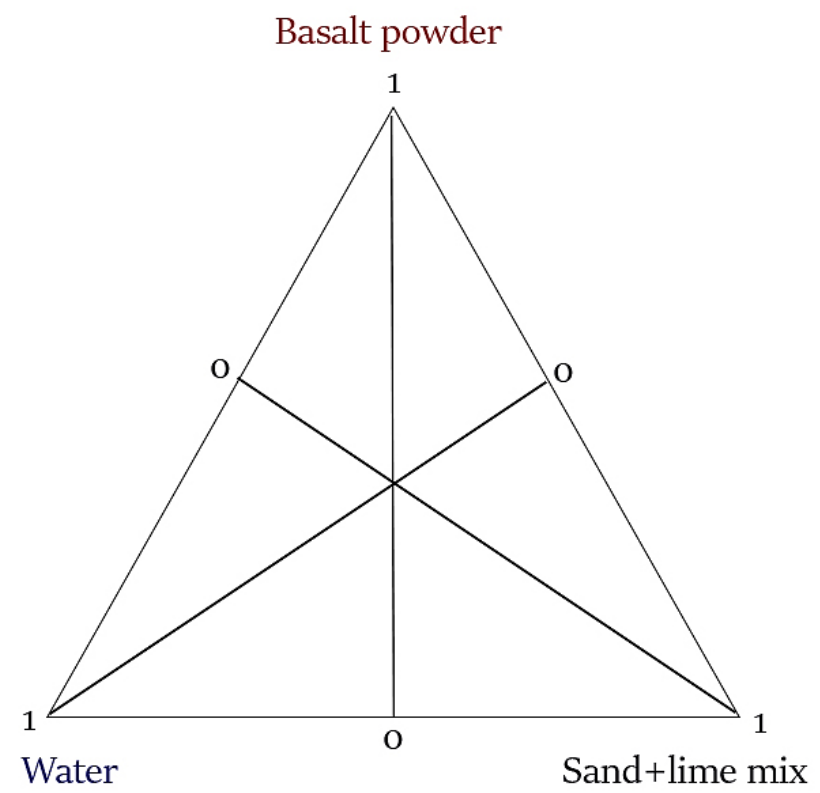
Figure 1. Model design of a mixture experiment with three independent variables.